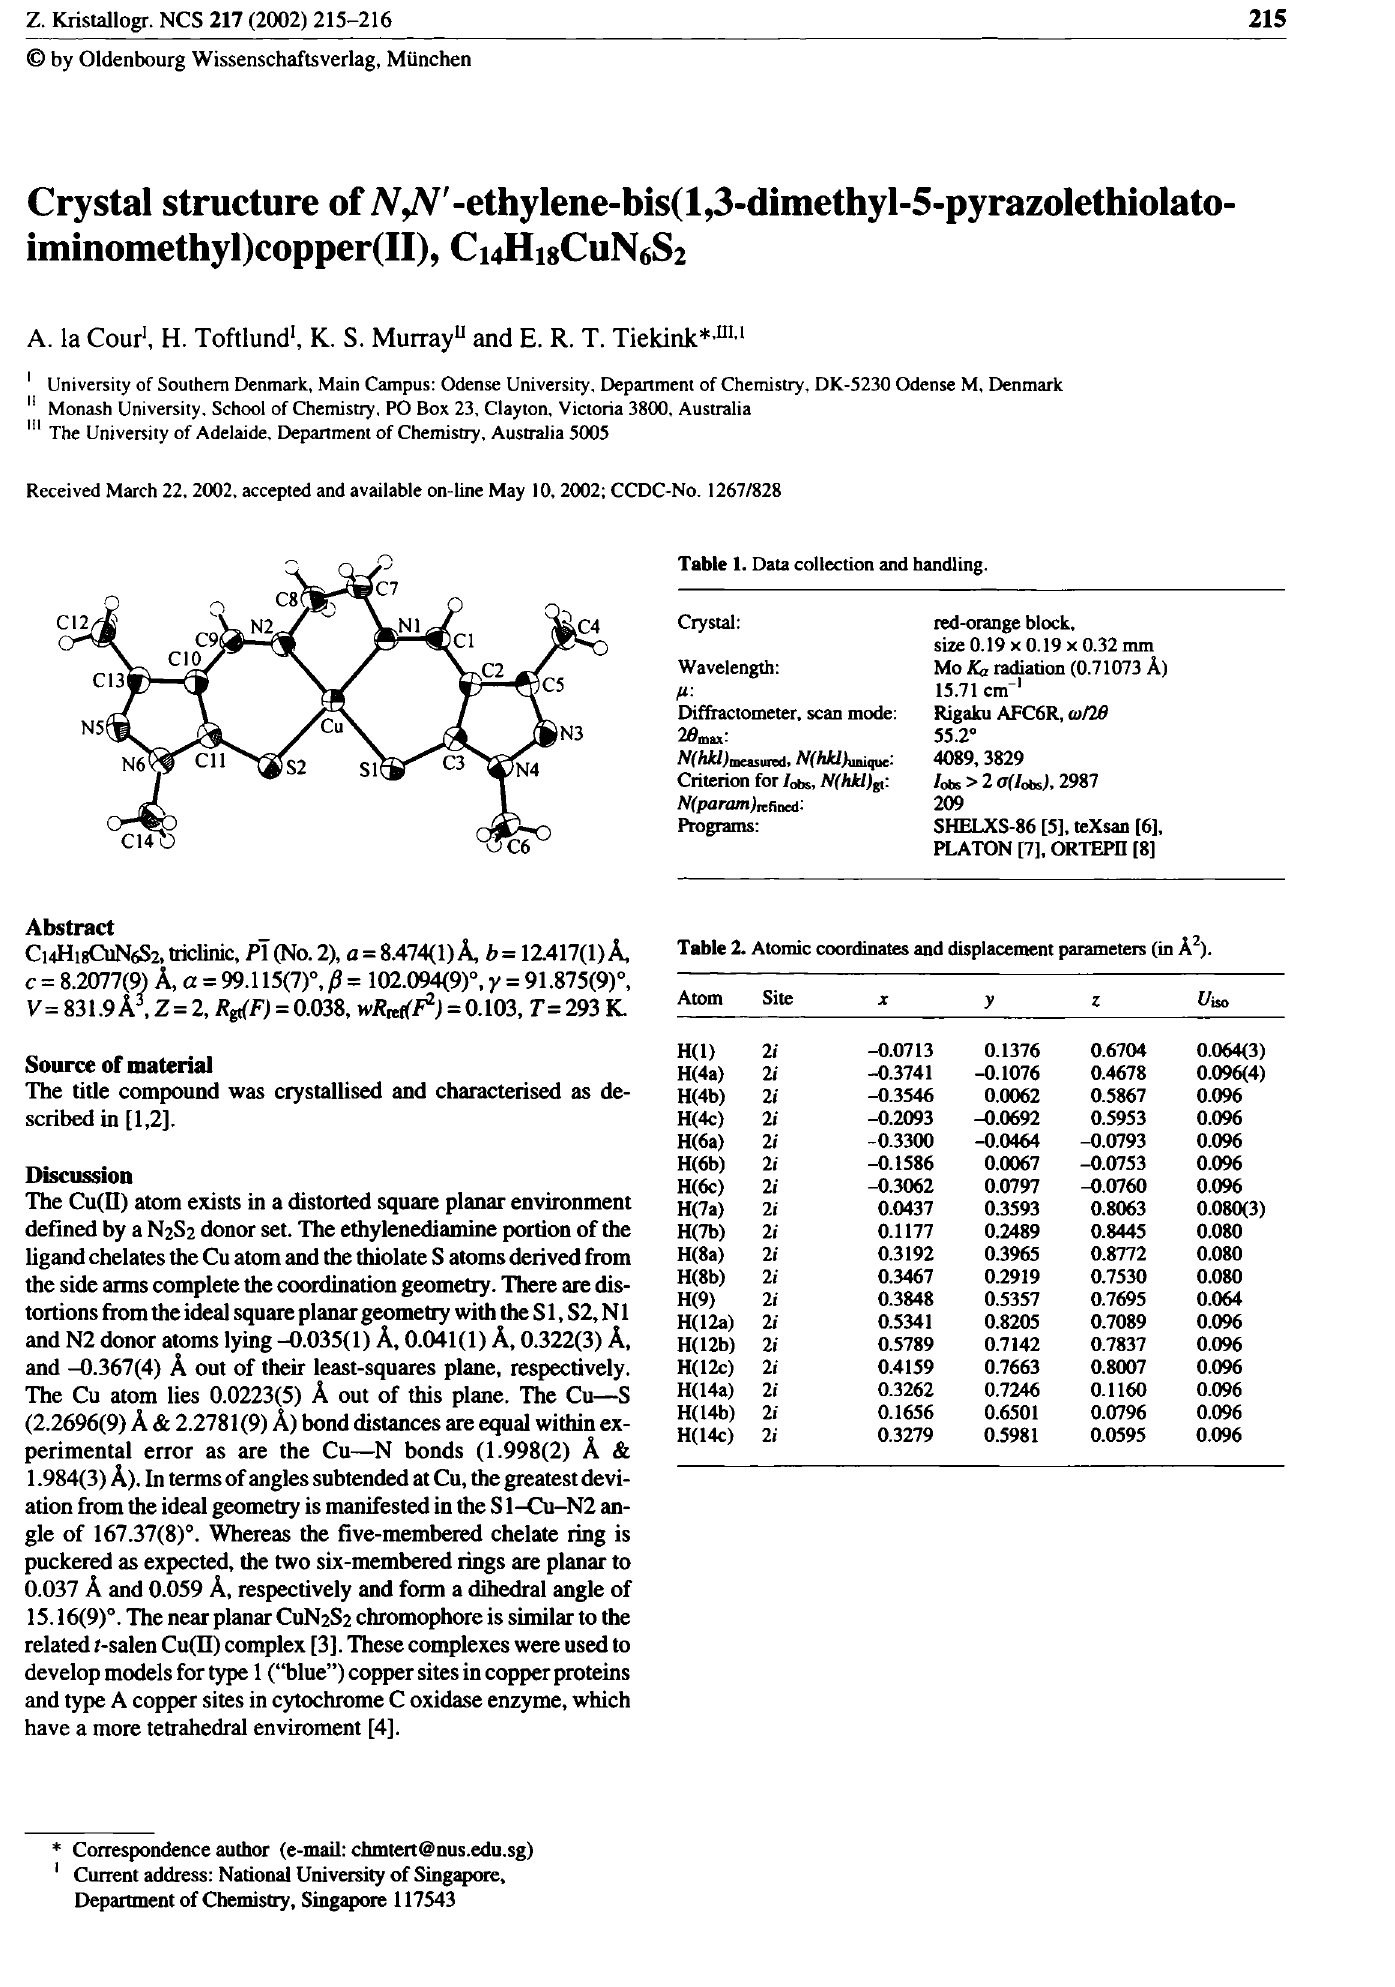
Table 2. Atomic coordinates and displacement parameters (in Â 2